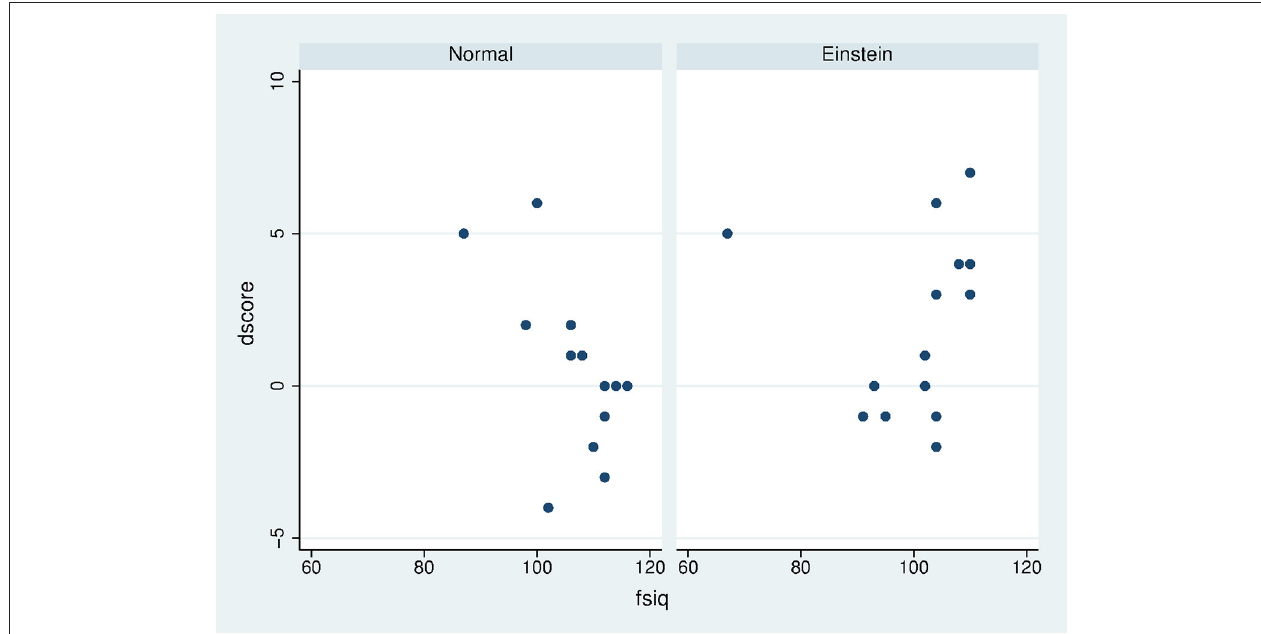
FIGURE 4 | Scatter diagram of dscore by fsiq and Body.